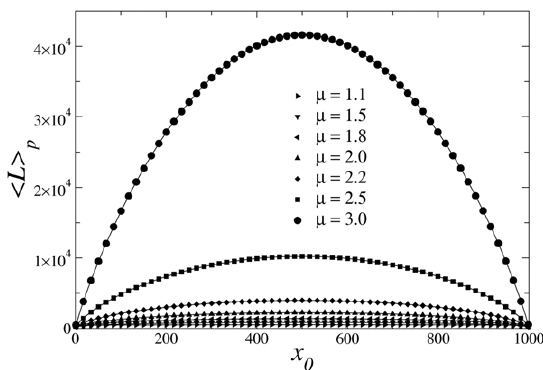
Figure 3. Nice adjustment of the average distance S L T p traversed between consecutive findings by a Le´vy random searcher starting at position x 0 . Results obtained by numerical discretization of Eq. (6) (solid lines) and multiple regression (symbols), for l ~ 10 3 and r v ~ 1 .